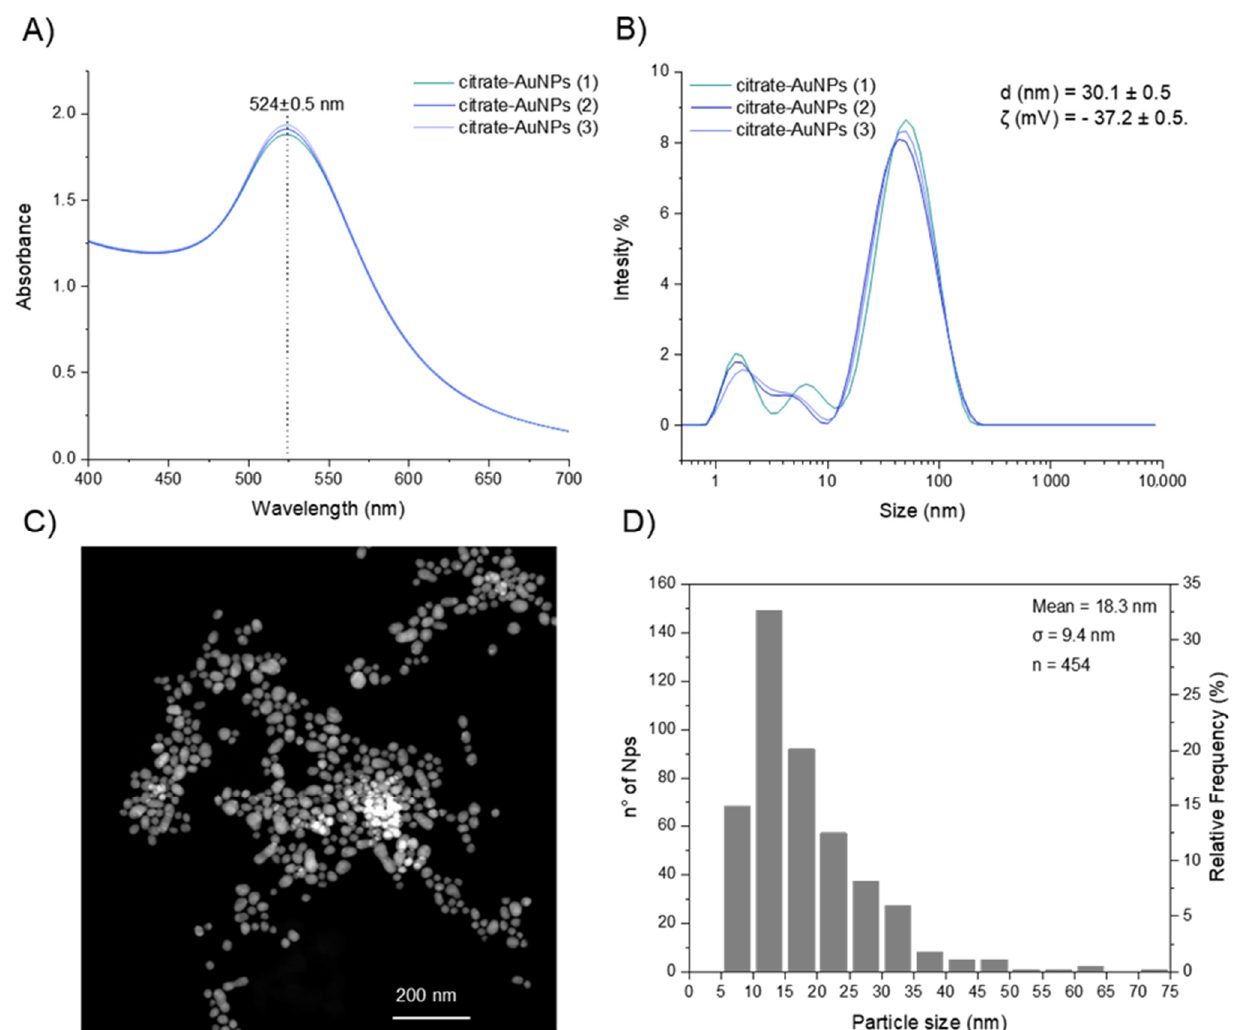
Figure 6. ( A ) UV–Vis absorbance spectra of gold colloid ( ≈ 0.012 nM Au particles). ( B ) Intensity-based DLS analysis of citrate AuNPs. ( C ) TEM images (with a sample of ≈ 5.3 nM Au particles) and ( D ) size distribution of colloidal nanoparticles (by TEM).